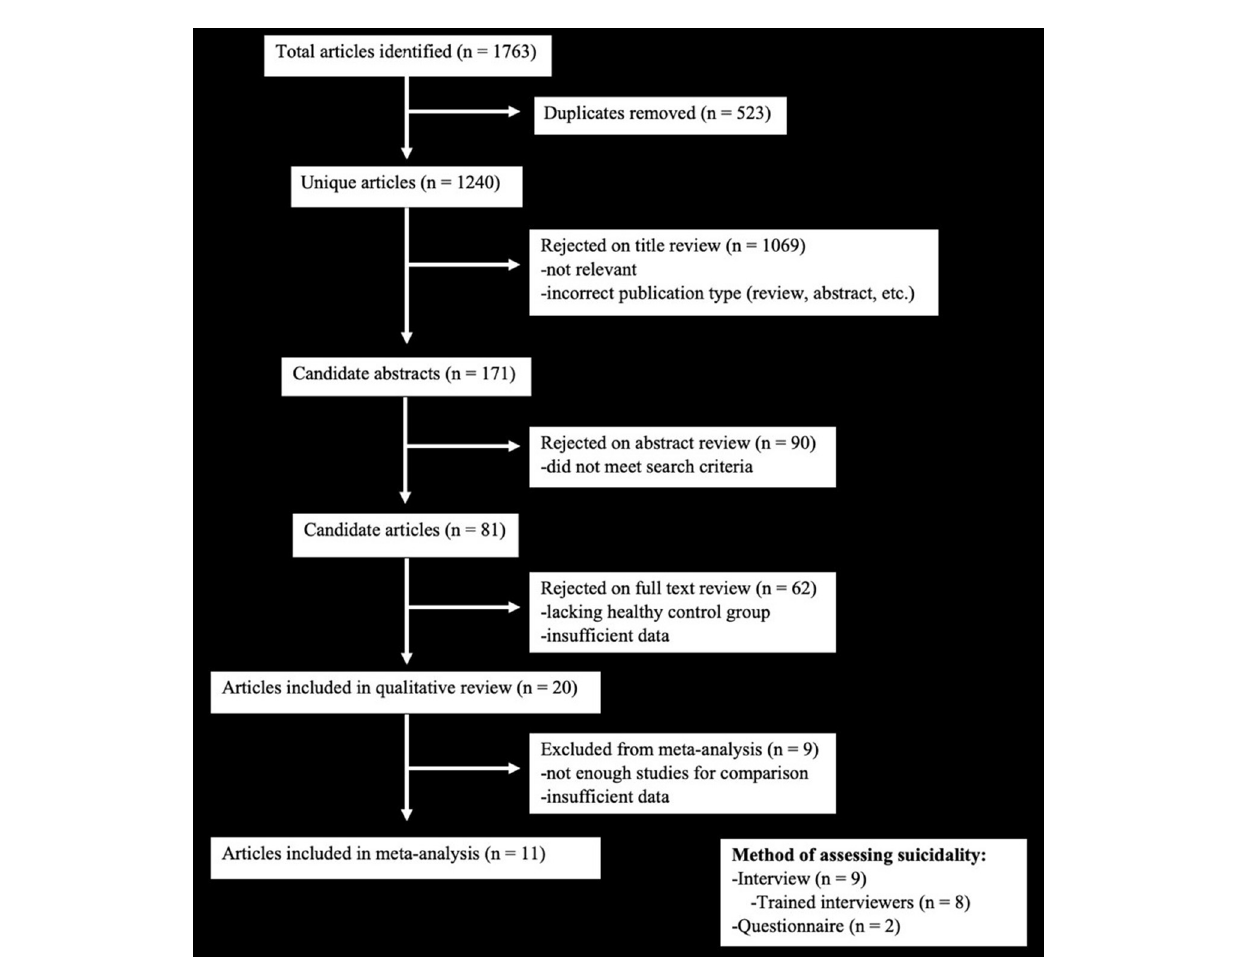
FIGURE1 PRISMA inclusion diagram for meta-analysis, which demonstrates the process through which the studies used in the manuscript were selected from the total number of studies